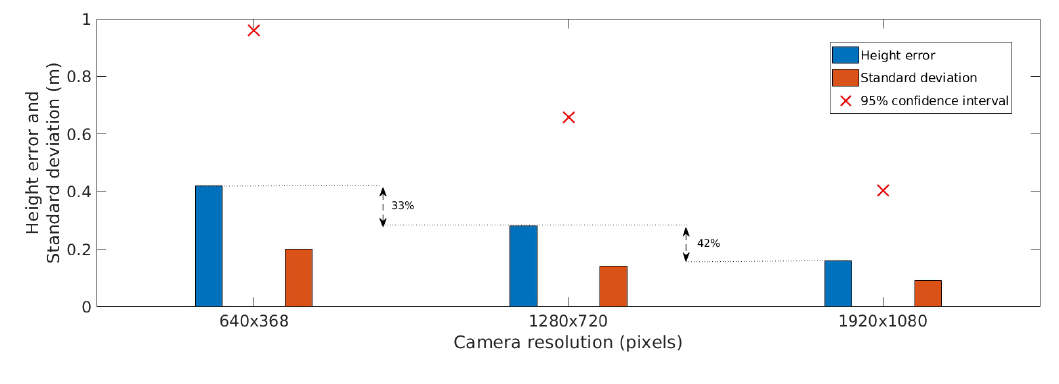
Figure 6. Horizontal orientation accuracy estimation for different camera resolutions.